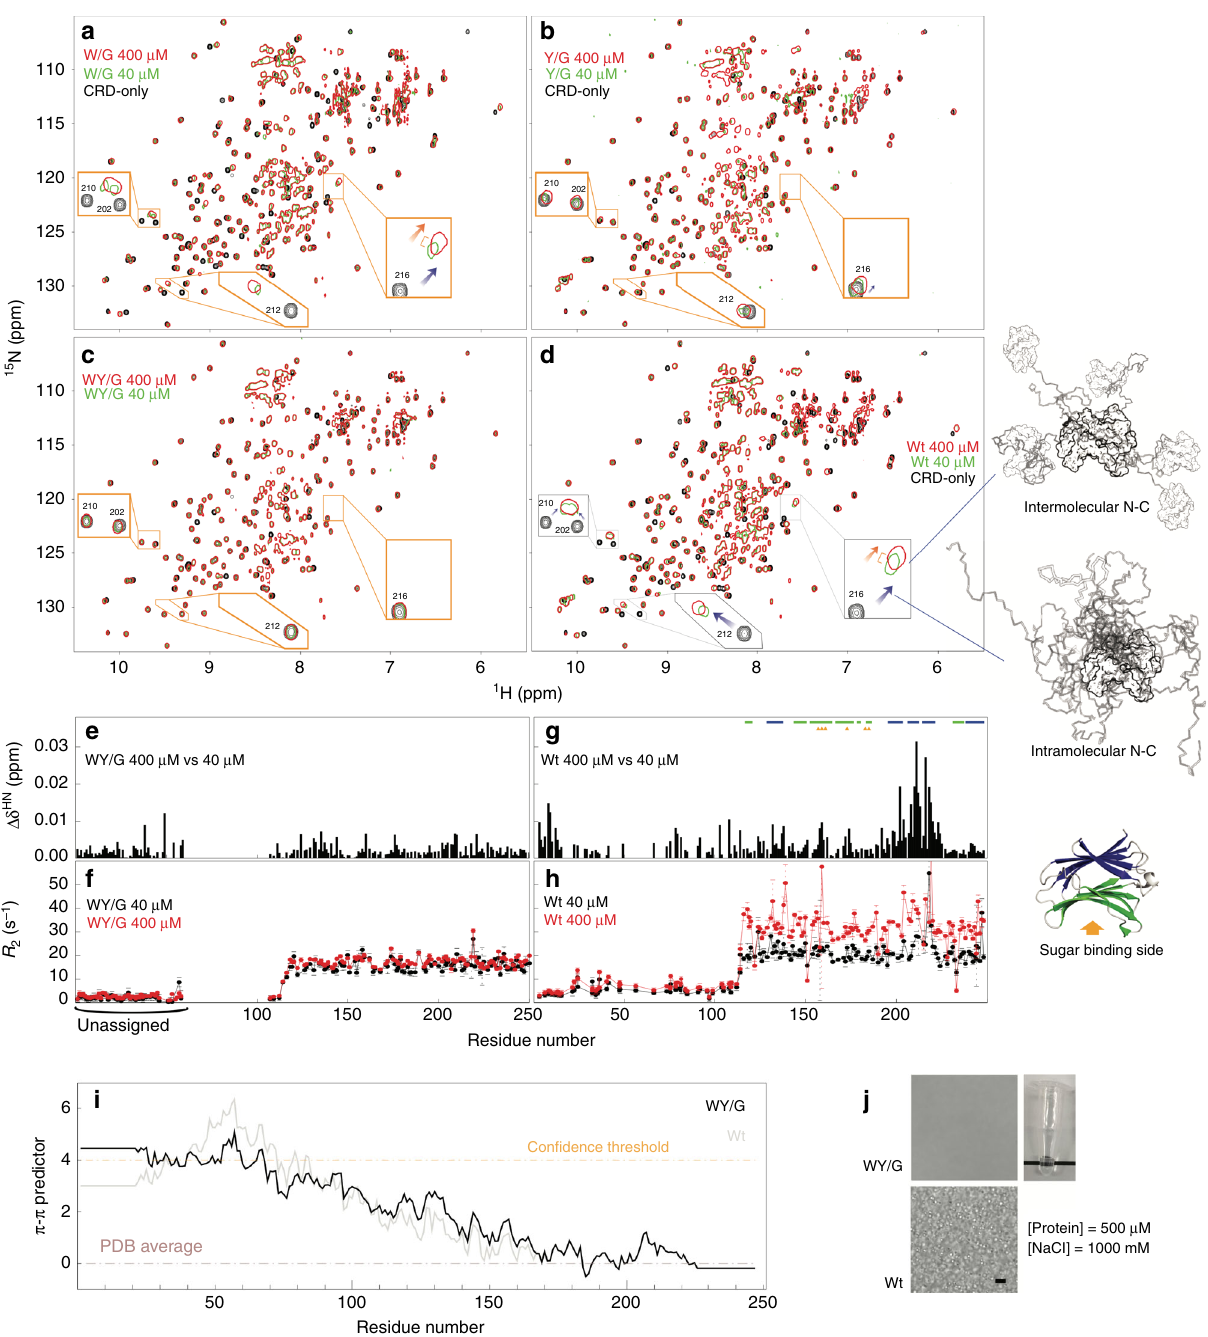
Fig. 4 Intermolecular and intramolecular interactions and liquid-liquid phase separation in full-length galectin-3. a – d NMR spectra of 400 (red) and 40 (green) µ M samples of the four full-length constructs of galectin-3 compared to those from the CRD-only construct (black, 400 µ M). Expanded views are shown of the regions in which the peaks shift the most. Blue arrows indicate chemical shift differences due to intramolecular NTD-CRD interactions (full- length spectra vs. the CRD-only spectrum); orange arrows indicate chemical shift differences due to intermolecular NTD-CRD interactions (400 vs. 40 µ M spectra). Schematic illustrations of these interactions are shown on the right of the fi gure. e , g Chemical shift and ( f , h ) transverse relaxation rate constant differences between 400 and 40 µ M samples for the WY/G mutant and the wild type. i Propensity to form π – π interactions of the WY/G construct. j Photograph and micrographs (scale bar: 10 µ m) of samples of the full-length galectin-3 variants under conditions corresponding to the two-phase regime of the phase diagram of full-length wild-type galectin-3 (Fig. 2f). Experiments were performed at least three times for each protein the propensity to assembly suggested by prion-likeness and π – π interaction sequence analysis, with the aromatic residues acting as “ stickers ” 6,66 (Fig. 3). These weak contacts lead to the formation of stronger assemblies when the protein concentration (i.e the number of stickers) is above the phase transition boundary. Our